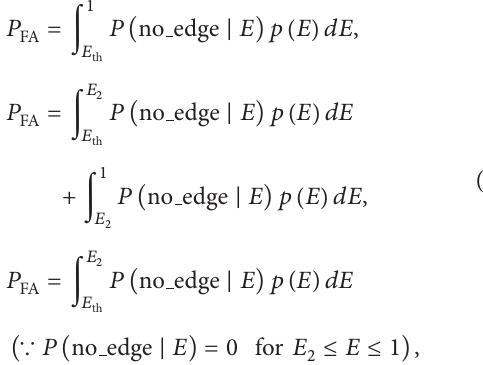
is not detected (misdetection) or when an actual non-edge pixel is marked as an edge pixel (false alarm). The